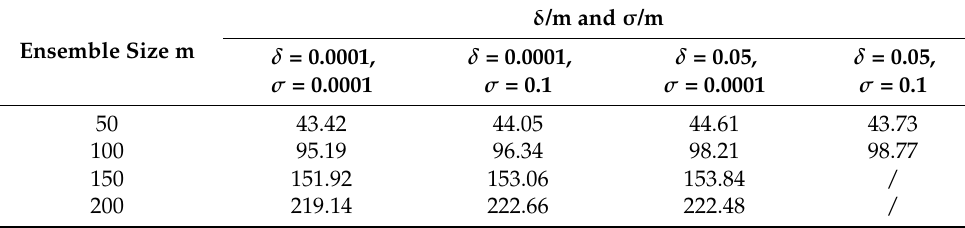
Table 5. Computational cost in seconds with different ensemble sizes at fixed δ and σ values.